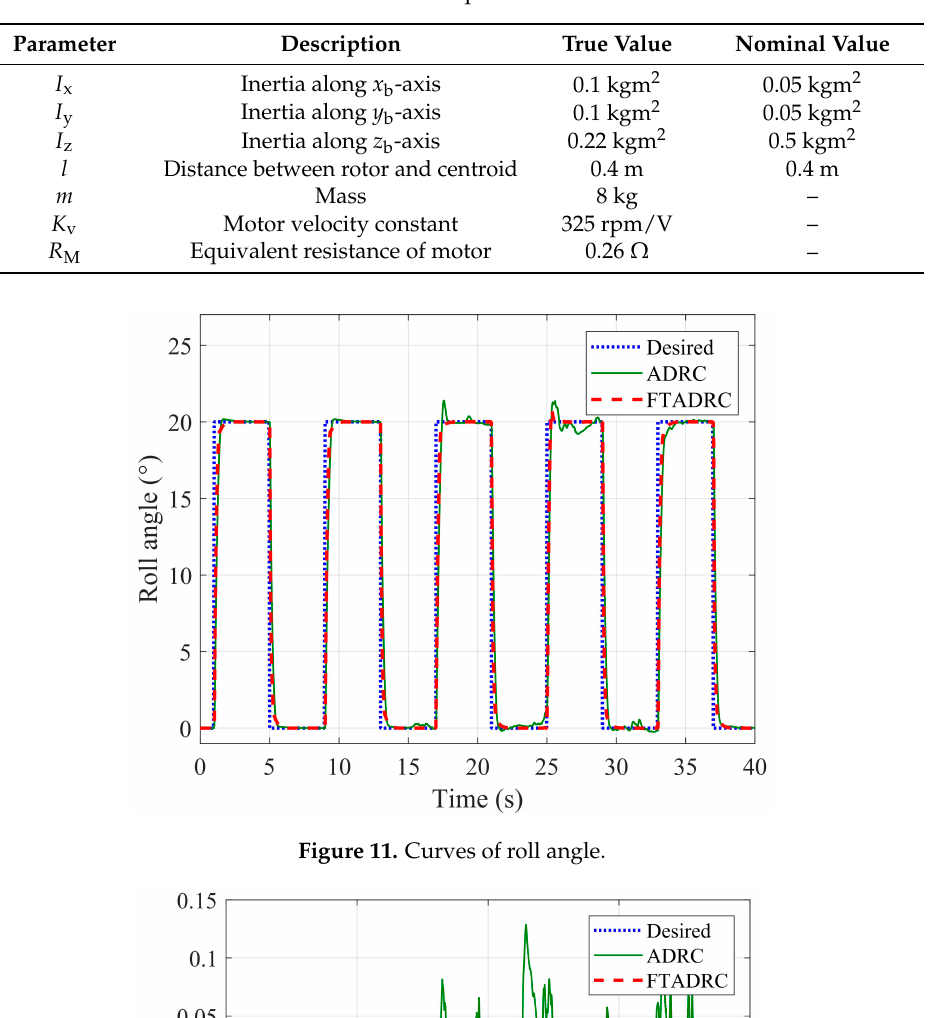
Table 3. Parameters of the quadrotor in simulations.